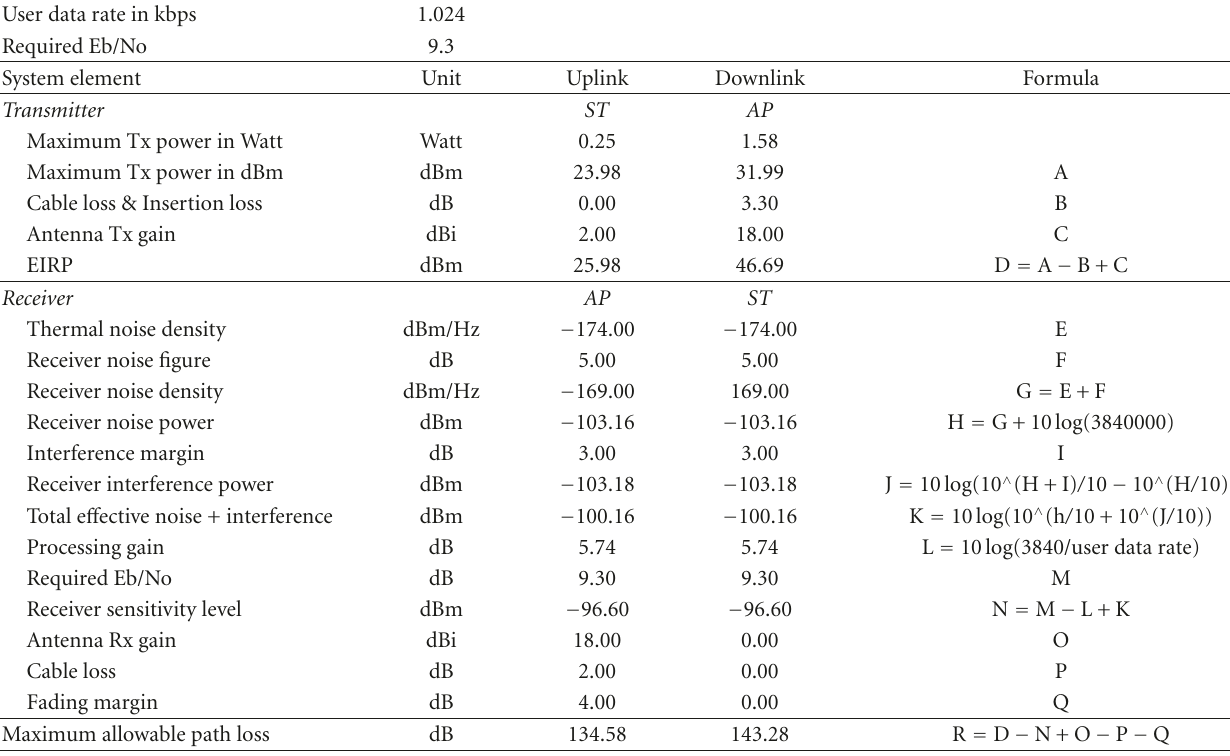
Table 3: Link budget calculation model.